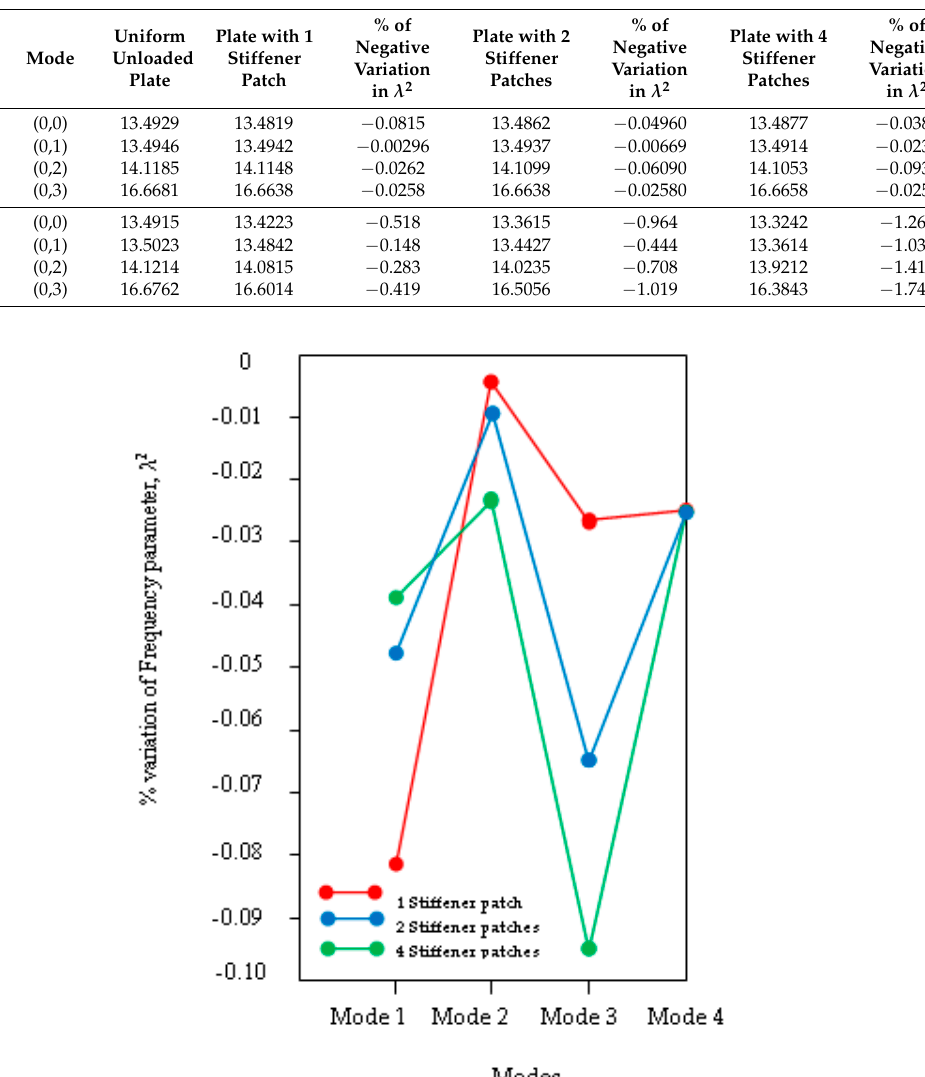
Figure 6. Comparison of % variation of natural frequency parameter with different modes for a uniform plate with taper ratio, T x = 0.00 and with different attachment of concentric stiffener patches.